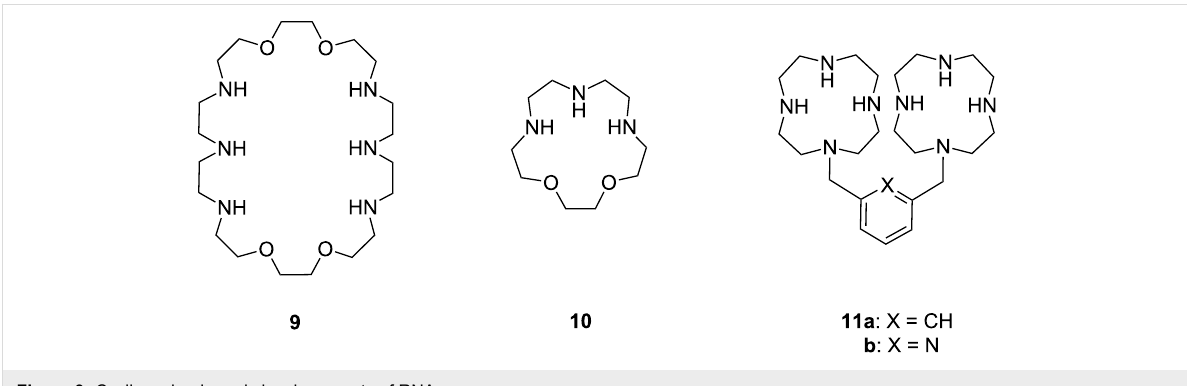
associative, which results in more marked acceleration com- pared to the background reaction [27]. Dinucleoside phos- phates containing uracil or guanine base were cleaved excep- tionally fast [82]. No mechanistic explanation was given. Inter- estingly, these two bases may undergo deprotonation under mildly basic conditions (p K a ≈ 9) in contrast to adenine and